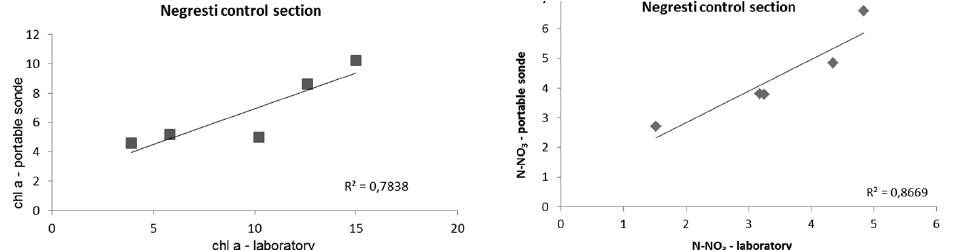
Fig. 4 Comparison of results for chlorophyll a (µg/L) and nitrates (mg/L) obtained in laboratory measurements and using portable sonde for the Negresti control section